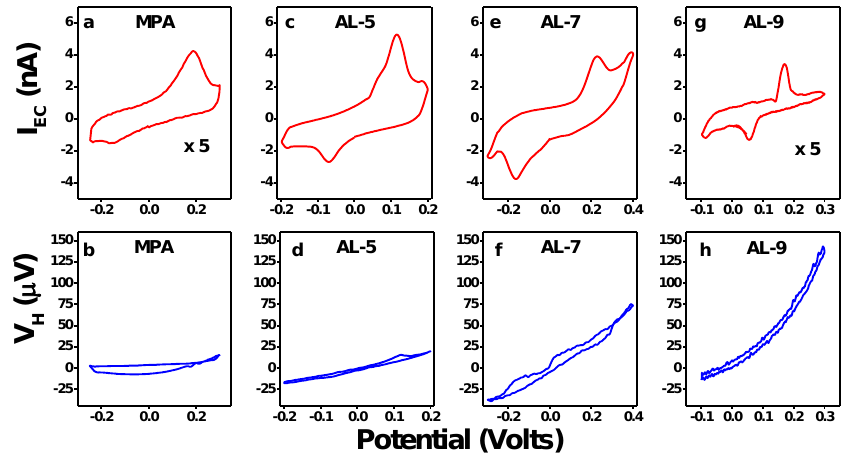
Figure 6. Electrochemical and Hall potential measurements. The reported results are obtained when the GaN device is coated with a self-assembled monolayer of achiral molecules (MPA: 3mercapto propanoic acid) ( a , b ) or with chiral α -helical oligopeptides of variable length L-SH-CH 2 -CH 2 -CO-{Ala-Aib} n -COOH, where n = 5, 7, and 9 for AL-5 ( c , d ), AL-7 ( e , f ), and AL-9 ( g , h ), respectively (Reproduced with permission from [28], WILEY-VCH, 2017).